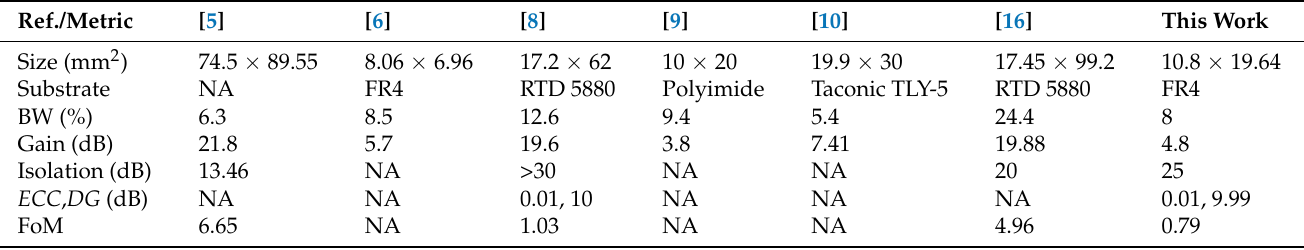
Figure 14. Simulated and measured scattering parameters of MIMO configuration-2. Table 3. Comparison of the proposed work with some existing FR2 band antennas in